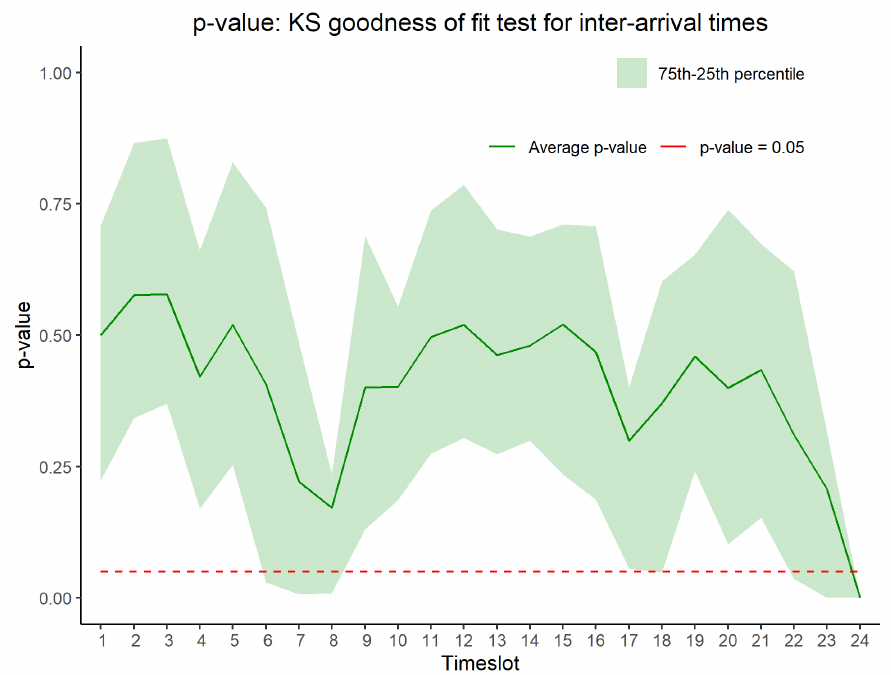
Figure 4. KS test p-values: For each ( m , d t ) combination, 24 KS tests were performed for each timeslot ( t s ). High p-values indicate that null hypotheses (IATs are exponentially distributed) could not be rejected.